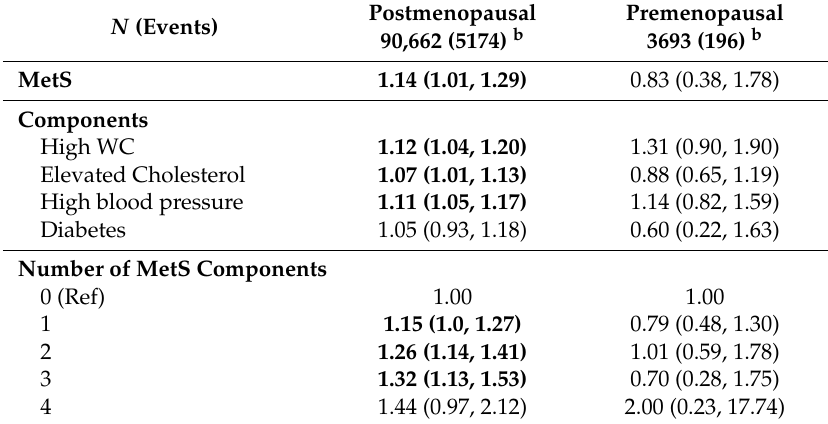
Table 4. Hazard ratios (HRs) a and 95% confidence intervals for MetS and breast cancer risk by menopausal